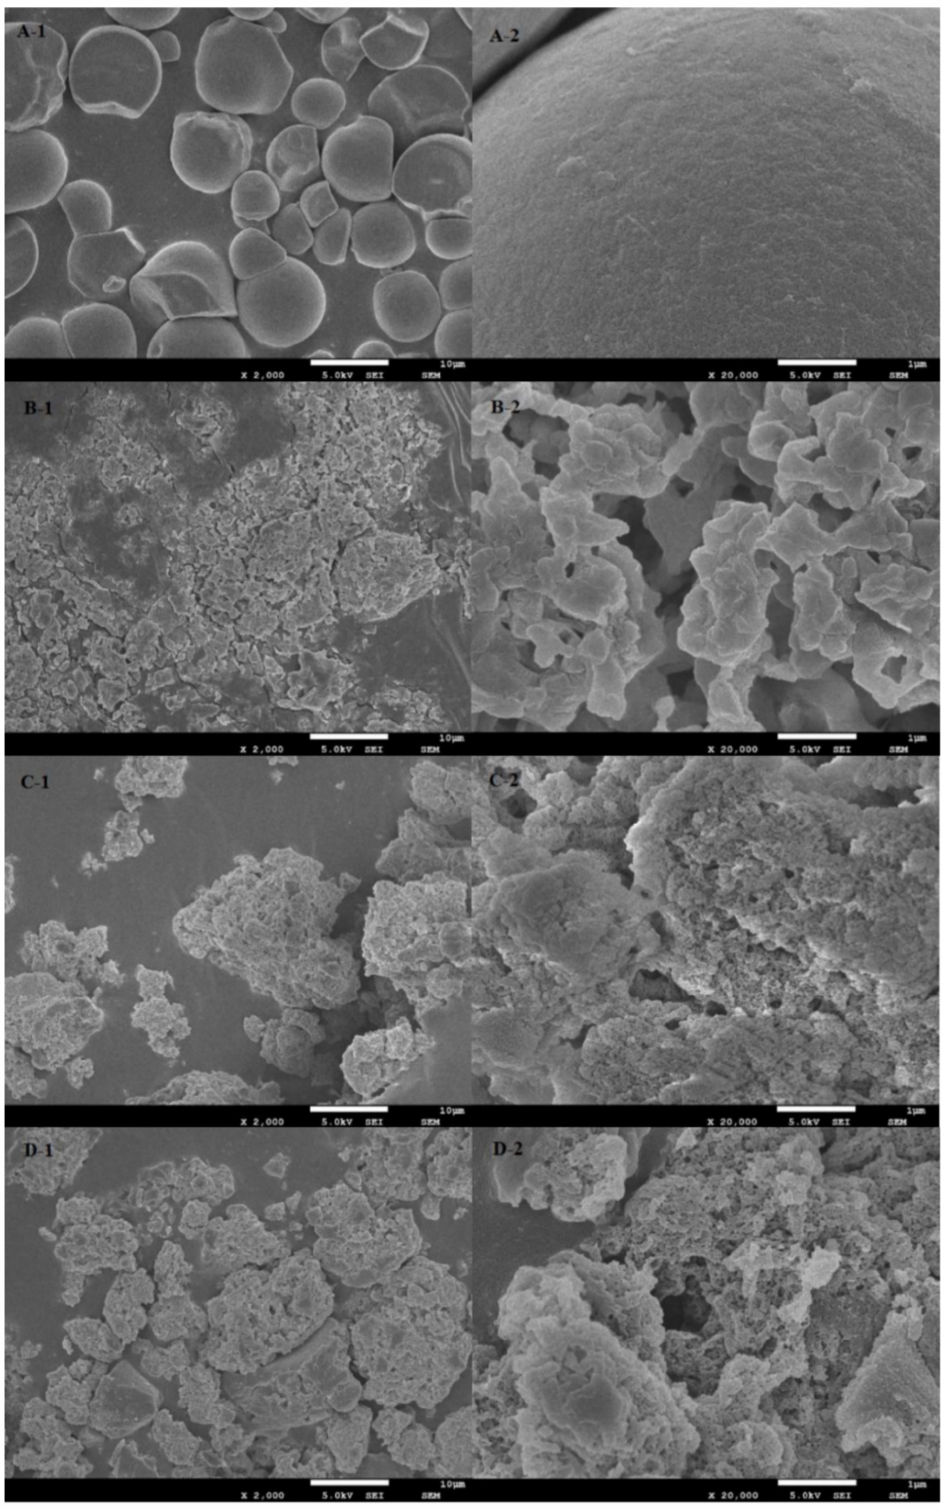
Figure 1. SEM photos of ( A ) cassava starch; ( B ) CA; ( C ) OSA-CA; ( D ) OSA-CA/Q, 1— × 2000; 2— ×